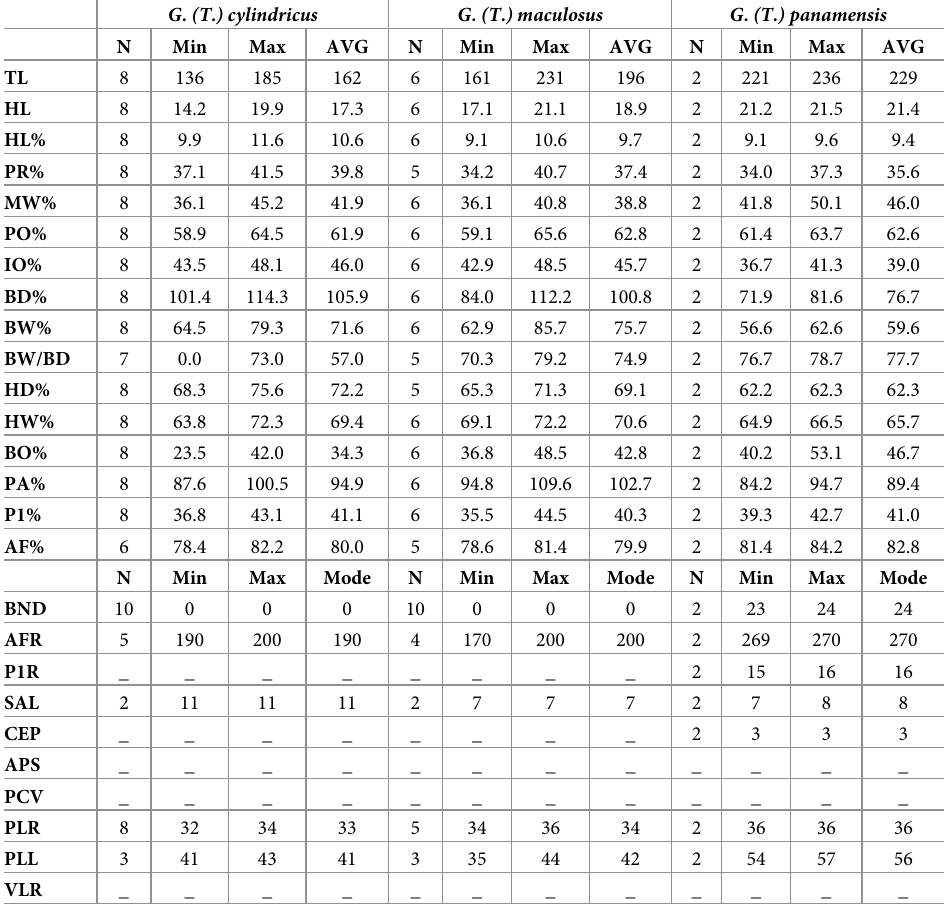
Table 17. Summary of morphometric and meristic data for three species of Tijax . Data for 22